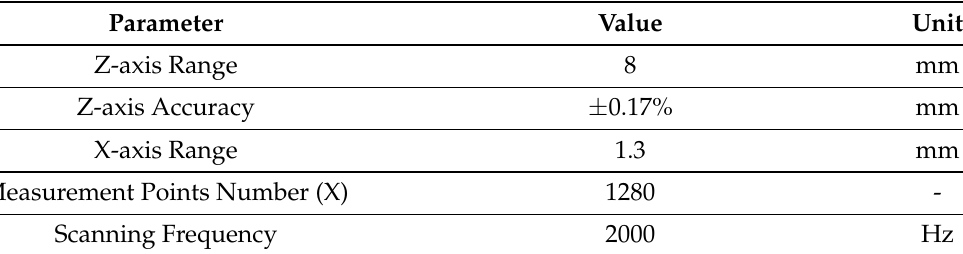
Table A3. Main Technical parameters of scanCONTROL